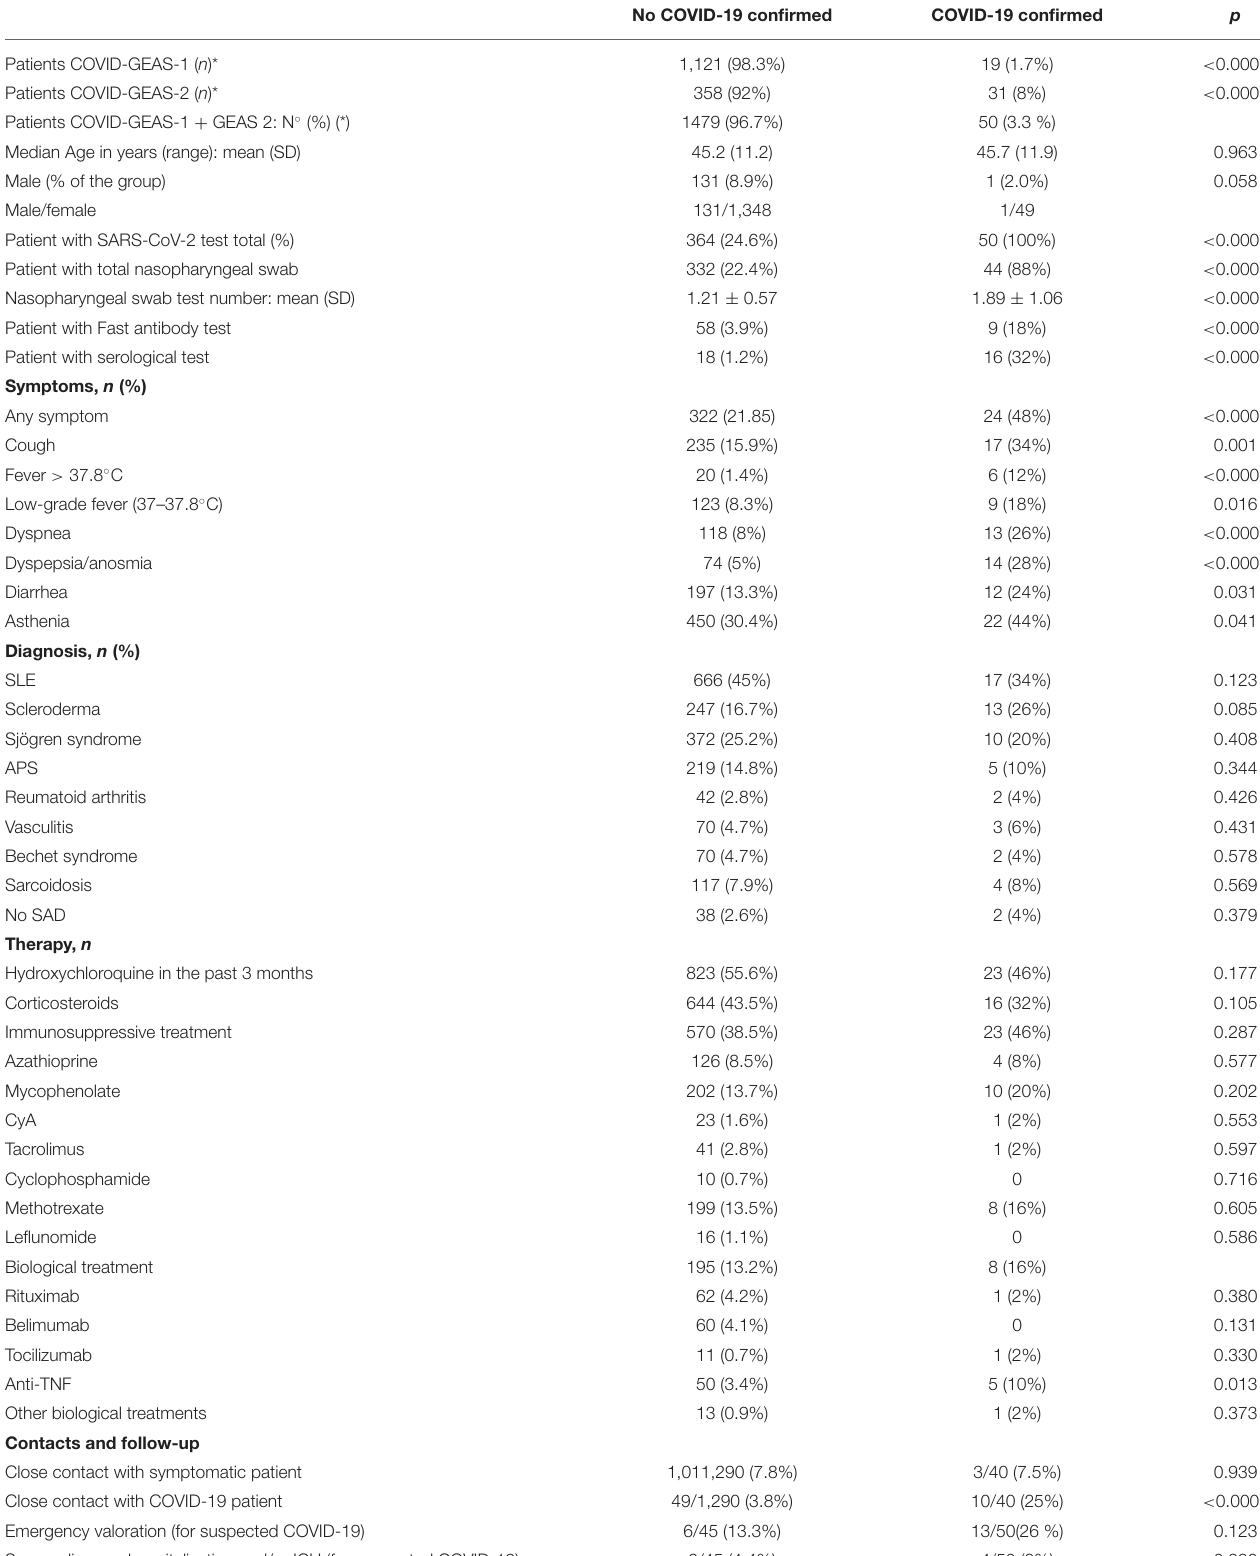
TABLE 2 | Comparison of patients diagnosed with SARS-CoV-2 infection. No COVID-19 confirmed COVID-19 confirmed p Patients COVID-GEAS-1 ( n )* 1,121